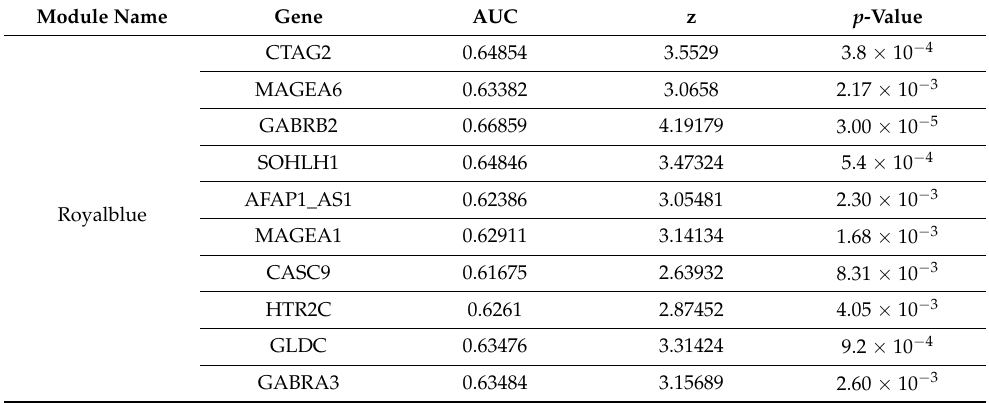
Table 3. ROC AUC scores and p -values for the top 10 genes based on their log fold change values.